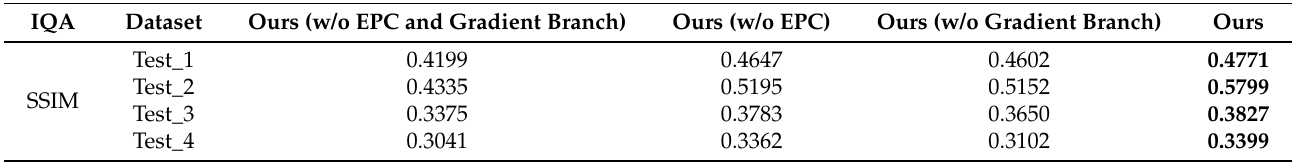
Table 4. Image quality assessment (IQA) results of ablation experiments. The best values for each quality index are shown in bold.